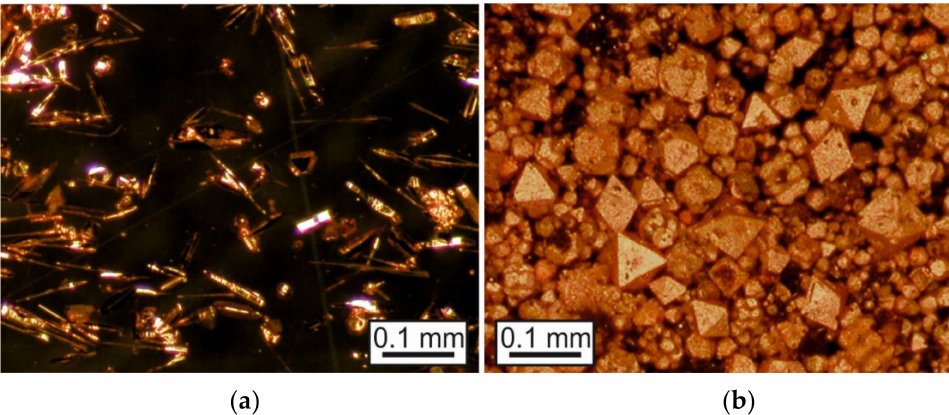
Figure 11. Influence of reducing agent on the shape of the resulting Cu crystals: ( a ) Spindles, cubes and polygonal individuals with L-ascorbic acid in use; ( b ) Cu octahedra obtained with hydrazine in